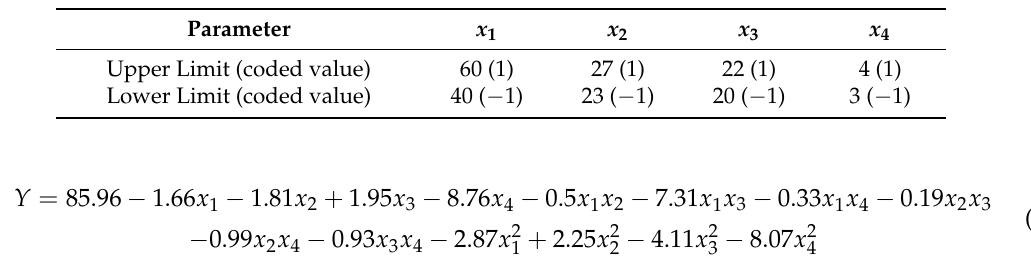
Table 3. HGA variable coding for the food case